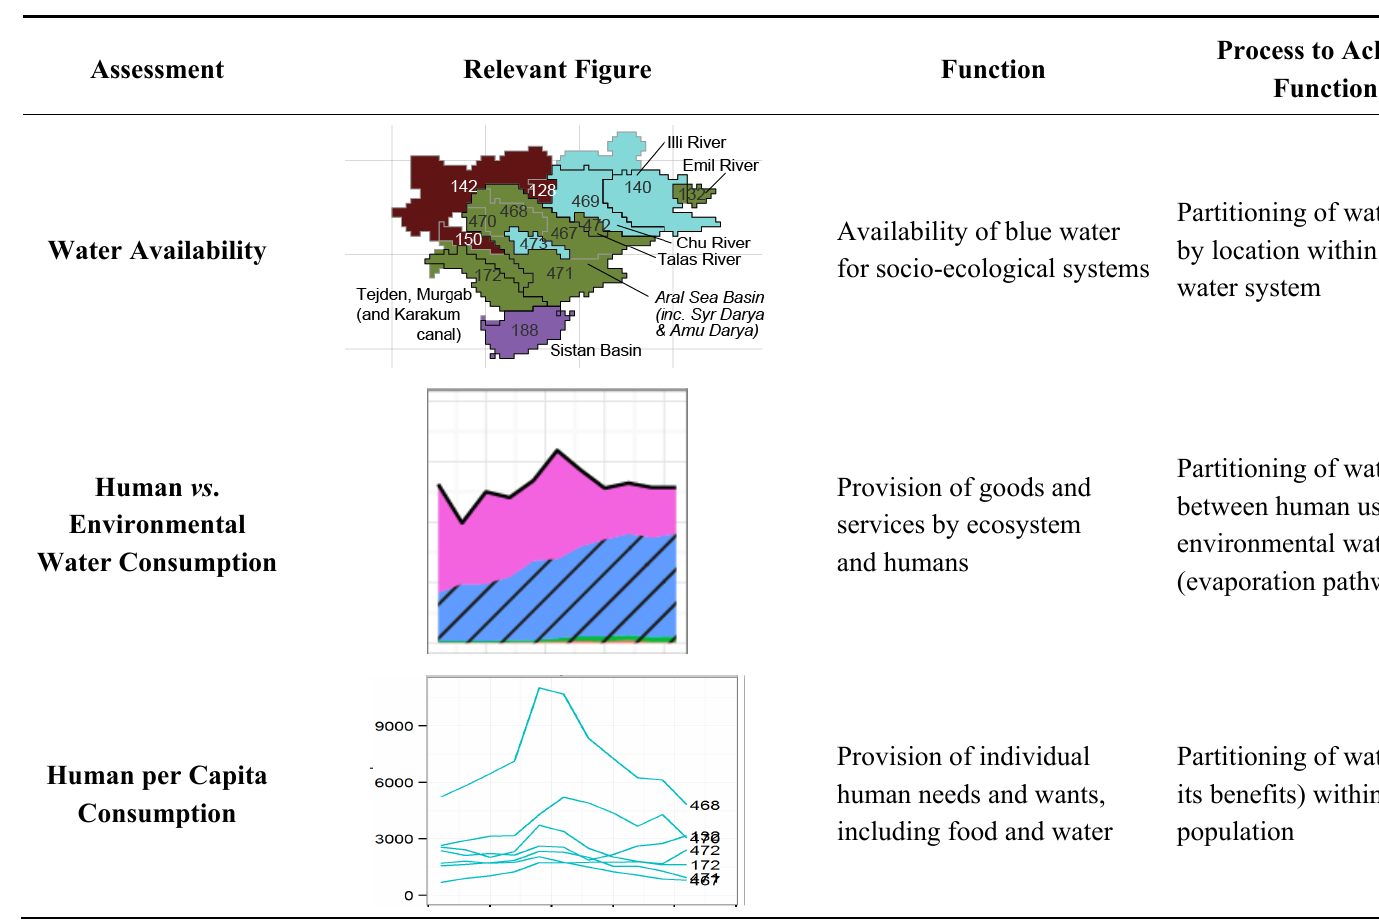
Table 1. Key functions and processes illustrated by each assessment in Section 3, and transformations that could occur after boundaries are crossed. Icons refer to Figures